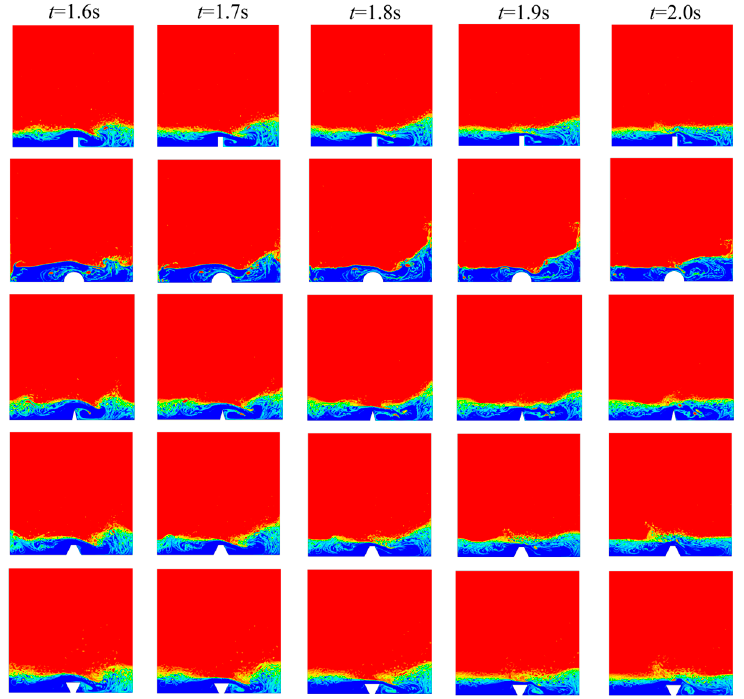
Figure 9. The free surface fl ow fi eld of obstacles of di ff erent shapes at 1.6–2.0 s.